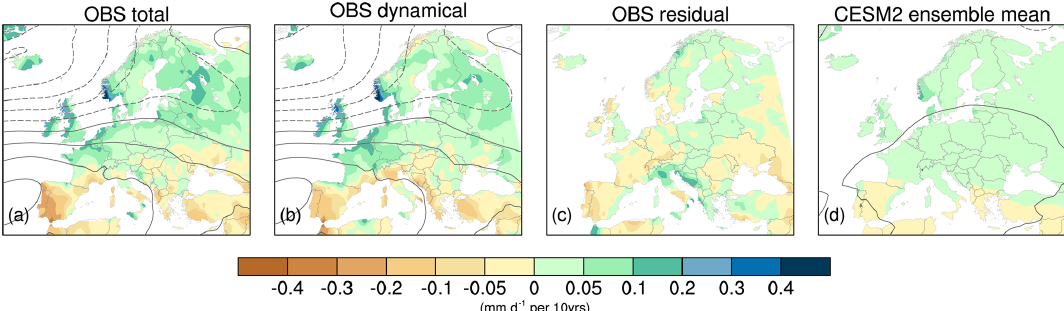
Figure 13. As in Fig. 12 but for precipitation (mmd − 1 per